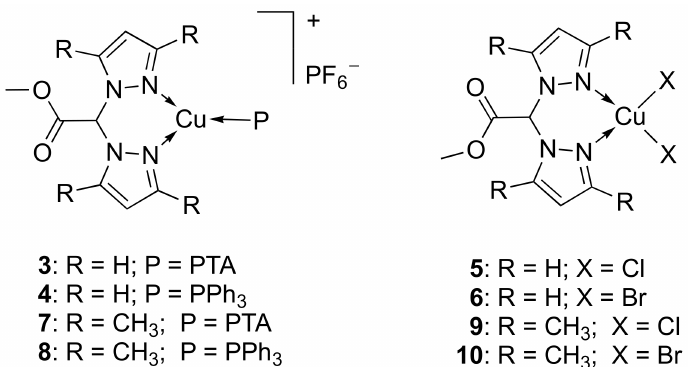
Figure 2. Chemical structures of complexes 3 – 10